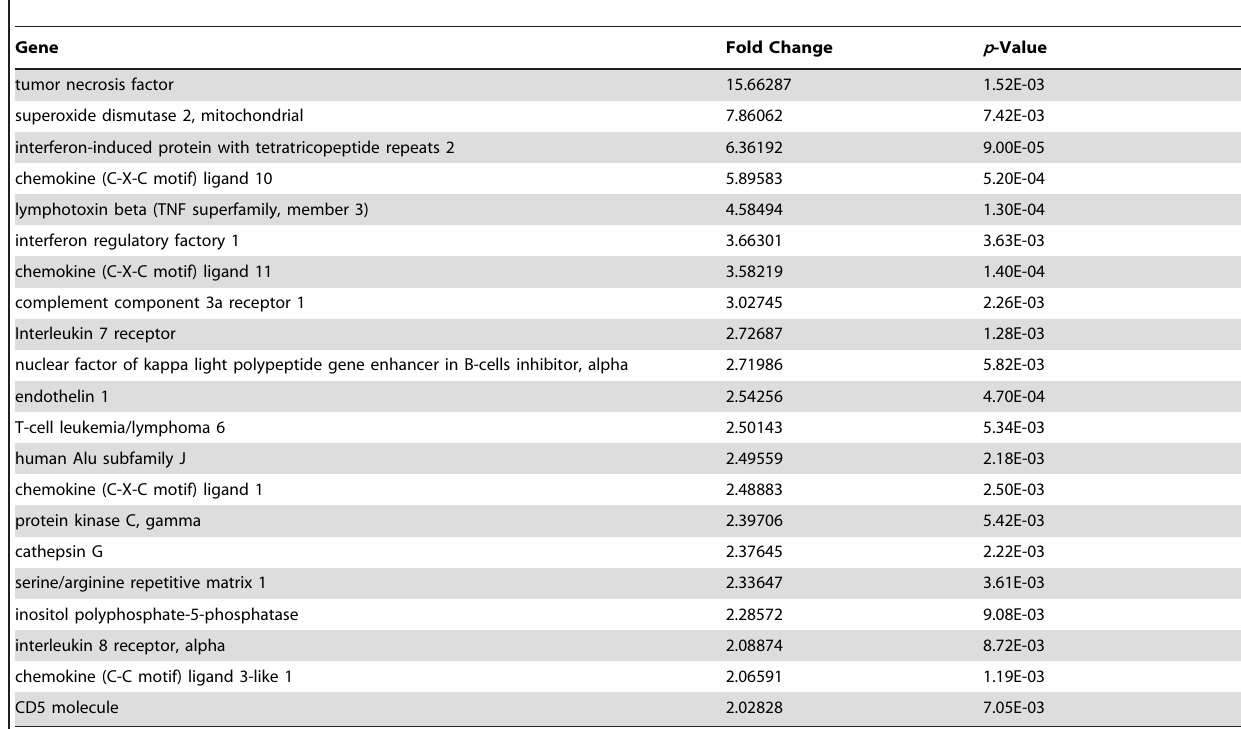
Table 2. List of significant genes associated with antiviral and innate immune responses that are induced by 10% Ino-RNA and not by